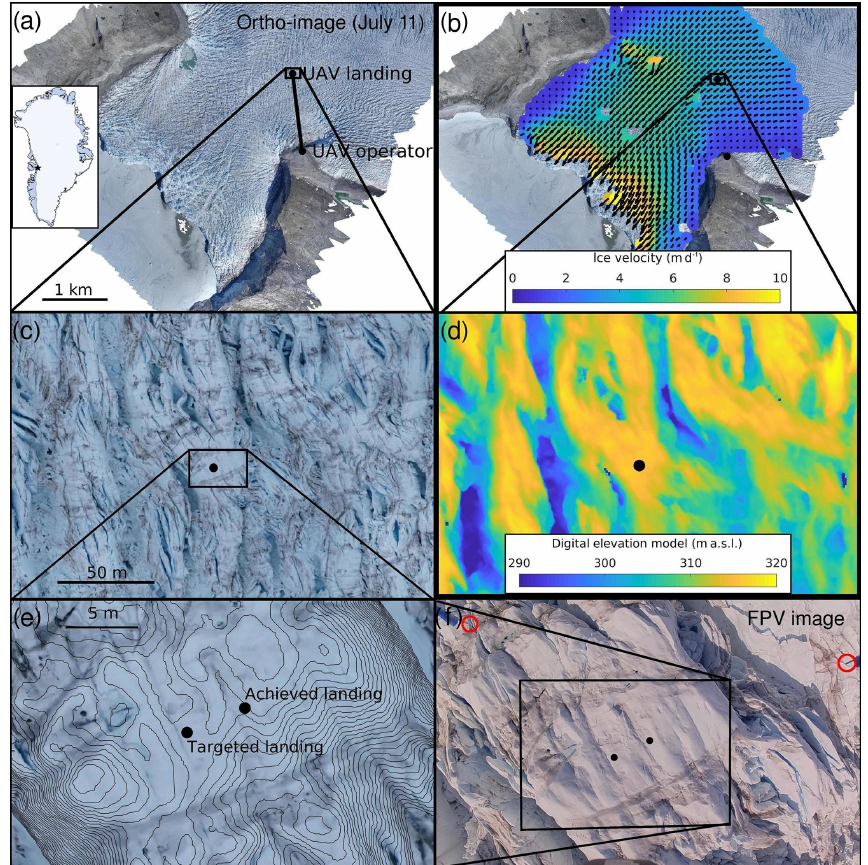
Figure 1. Ortho-images (a, c, e) , velocity field (b) , DEM (d) , and aerial picture (f) of Eqip Sermia Glacier. (a) Ortho-image processed from UAV images taken during the 11 July large-scale reconnaissance flight together with a map of Greenland (source: Wikimedia Commons) indicating the location Eqip Sermia Glacier by a star. (b) Horizontal ice velocity field inferred by template matching of the ortho-images of the 6 and 11 July flights; (c) 11 July ortho-image around the landing site; (d) 11 July DEM around the landing site; (e) 11 July detailed ortho-image showing the targeted and the achieved landing sites. The position of the achieved landing site was corrected to account for the displacement of ice between 11 and 13 July. Contour lines (20cm intervals) were drawn to reflect the local topography of the glacier. (f) Example of FPV image used by the UAV operator to adjust the touching point during the landing stage. Two of the four spikes installed under the legs of the UAV are visible on the top left and top right corners (red